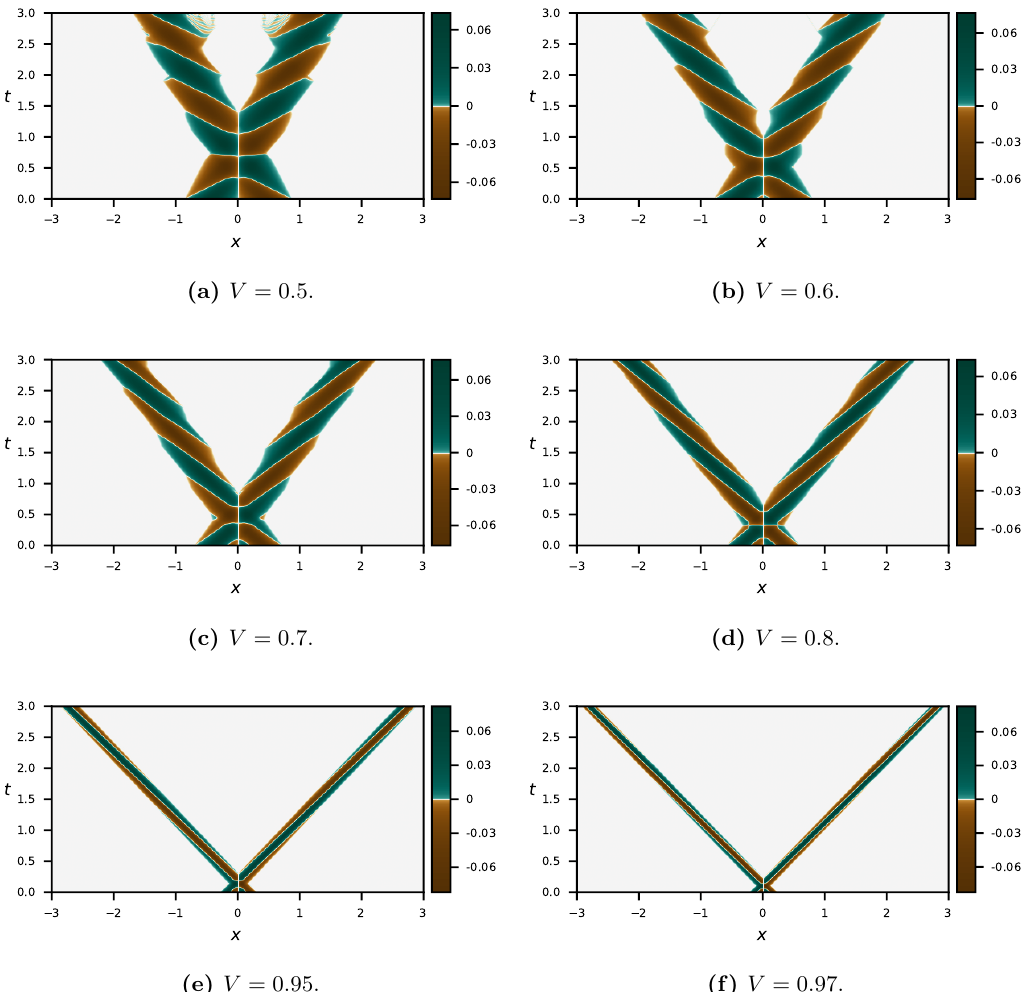
Figure 13 . The dependence of the scattering of oscillons (antisymmetric con(cid:12)guration) on their initial speed V . The initial con(cid:12)guration contains oscillons with phase (cid:11) = 0 and no zig-zag motion of their